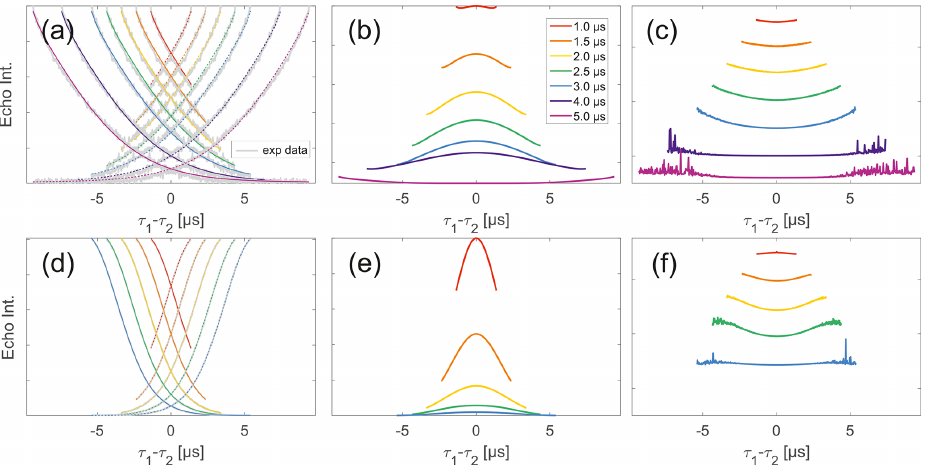
Figure 5. Analysis of two-pulse decay and refocussed echo data on 50µM monoradicals in OTP. Panels (a) – (c) show data of nitroxide monoradical (1); (d) – (f) show data of trityl monoradical (2). two-pulse decays with corresponding SSE fits (grey), mirrored and aligned to reflect offsets τ 1 and τ 2 in the SIFTER experiment (a, d) , product of the fits of the aligned decay traces (b, e) and result from division by corresponding SIDRE traces (c, f) (reflecting B S ) are shown. Traces in (c) and (f) are displayed in stack plots at arbitrary